Question: In a single sentence, describe what this figure presents.
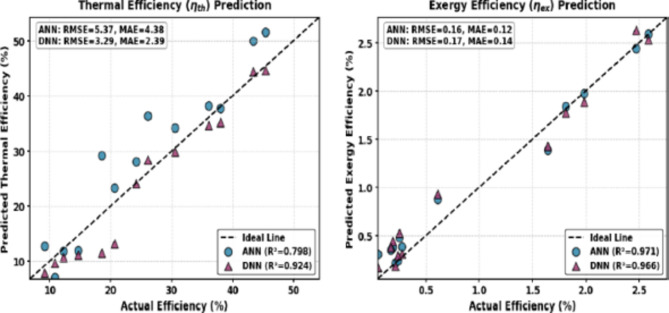
Answer: Scatter plots for thermal and exergy efficiencies.